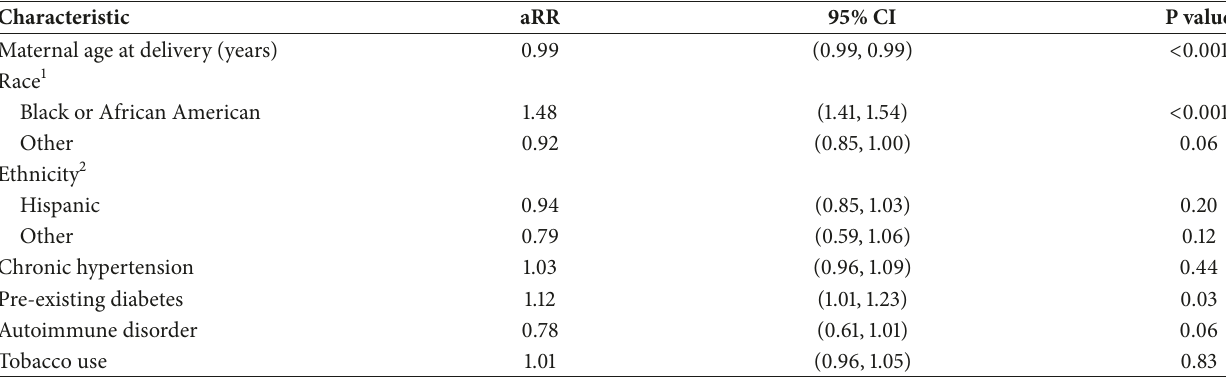
Table 2: Multivariate predictors of GBS